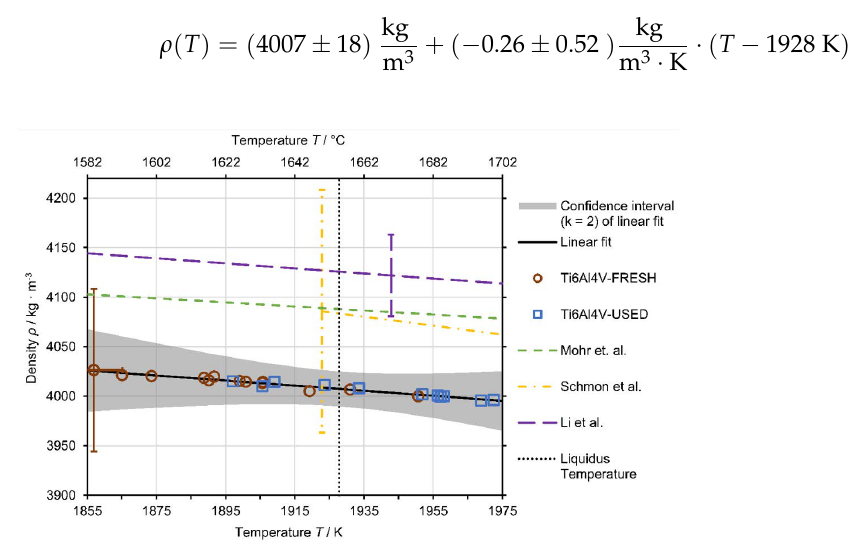
Figure 8. Results of the single density measurements of the FRESH Ti6Al4V in red circles and USED Ti6Al4V in blue squares. The measurement uncertainty for the individual data points is represented by only one uncertainty bar to facilitate better readability of the figure. The solid black line shows the linear fit of all data in accordance with the model (9), the confidence interval (k = 2) for the fit is the shaded grey area (see Appendix A.2.5 for more information about the uncertainty analysis). As a comparison, reference data by Mohr et al. [49] ( µ -g experiment on-board the ISS) are plotted as a green dashed line, (extrapolated) data by Schmon et al. [52] (exploding wire technique) as a yellow dash dotted line and data by Li et al. [53] (electrostatic levitation) as a long-dash purple line. Their respective uncertainty estimates (if given) are visualized by the corresponding uncertainty bars. The liquidus temperature of 1928 K by Boivineau et al. [47] is plotted as a black dotted